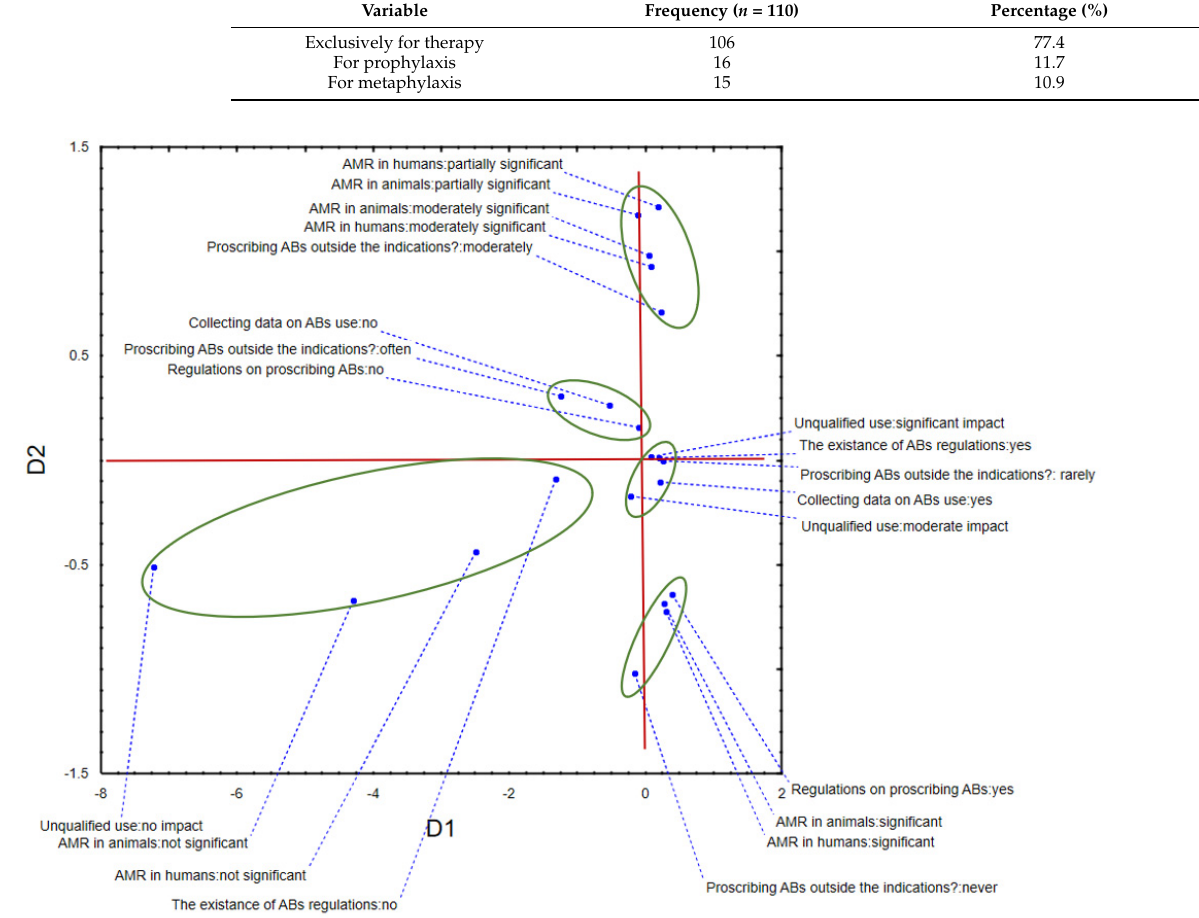
Figure 1. The position of respondents’ answers in space defined by the first two multiple correspondence axes—rational prescribing of antibiotics.